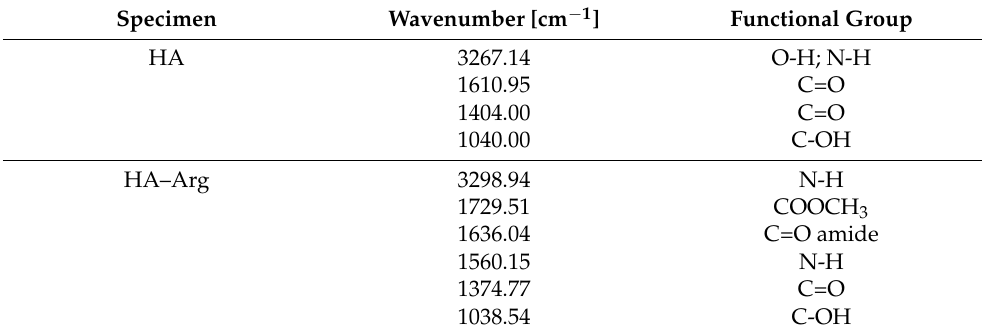
Table 1. Position of main bonds (cm − 1 ) in IR spectra of hyaluronic acid before and after